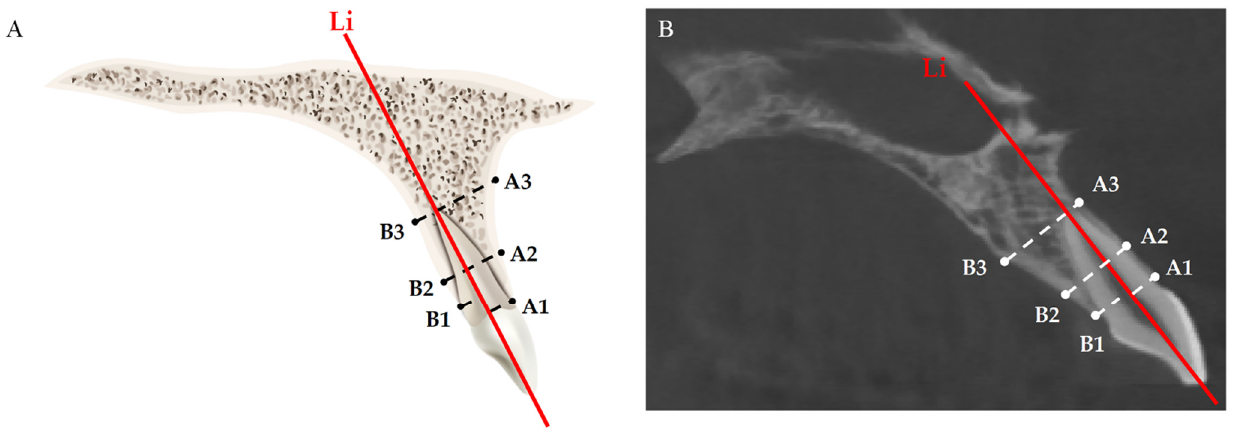
Figure 5. ( A ) Schematic diagram of the measurement of the alveolar bone thickness at crestal, mid- root, and apical levels. A1–Li, labial alveolar bone thickness at crestal level; A2–Li, labial alveolar bone thickness at mid-root level; A3–Li, labial alveolar bone thickness at apical level; B1–Li, palatal alveolar bone thickness at crestal level; B2–Li, palatal alveolar bone thickness at mid-root level; B3–Li, palatal alveolar bone thickness at apical level; ( B ) measurements on actual CBCT images.